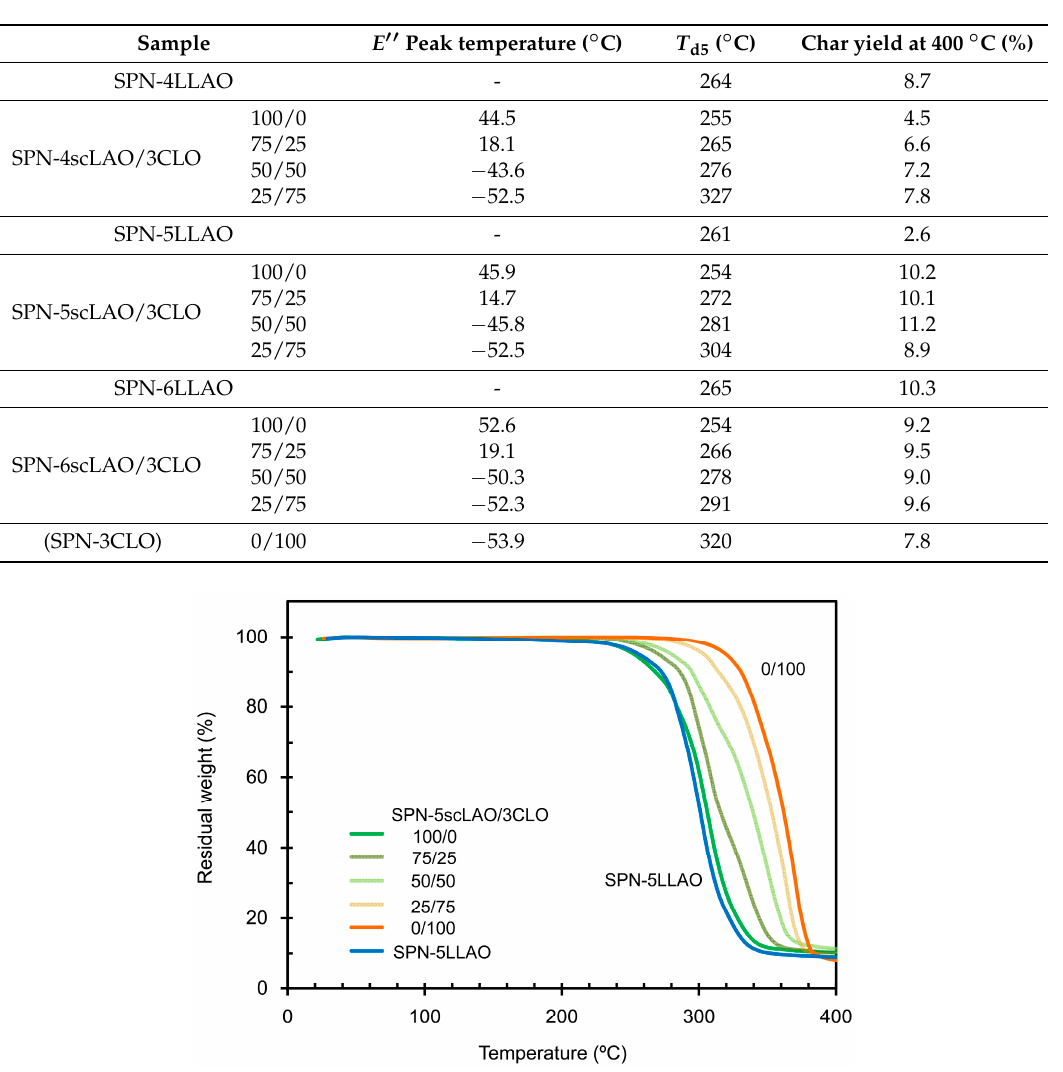
Table 4. E (cid:48)(cid:48) peak temperatures of SPN- m scLAO/3CLOs ( m = 4, 5 and 6) and TGA data for SPN- m LLAOs and SPN- m scLAO/3CLOs ( m = 4, 5 and 6).